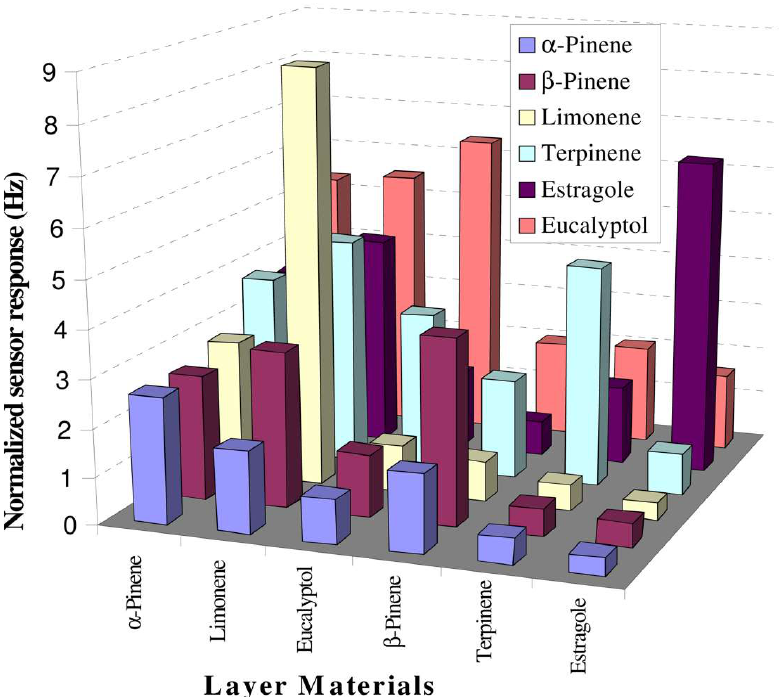
Figure 7. Sensitivity and selectivity of identically produced porogen imprinted polymers with different templates. Some MIPs (layer materials) show a strong selectivity and response to their imprinting molecule, while others do not. QCM–MIP sensors were produced using an experimentally determined optimal composition of 1:1.5:10 functional monomer (styrene) to crosslinker (divinylbenzene) to template ratio. Reproduced with permission [140].